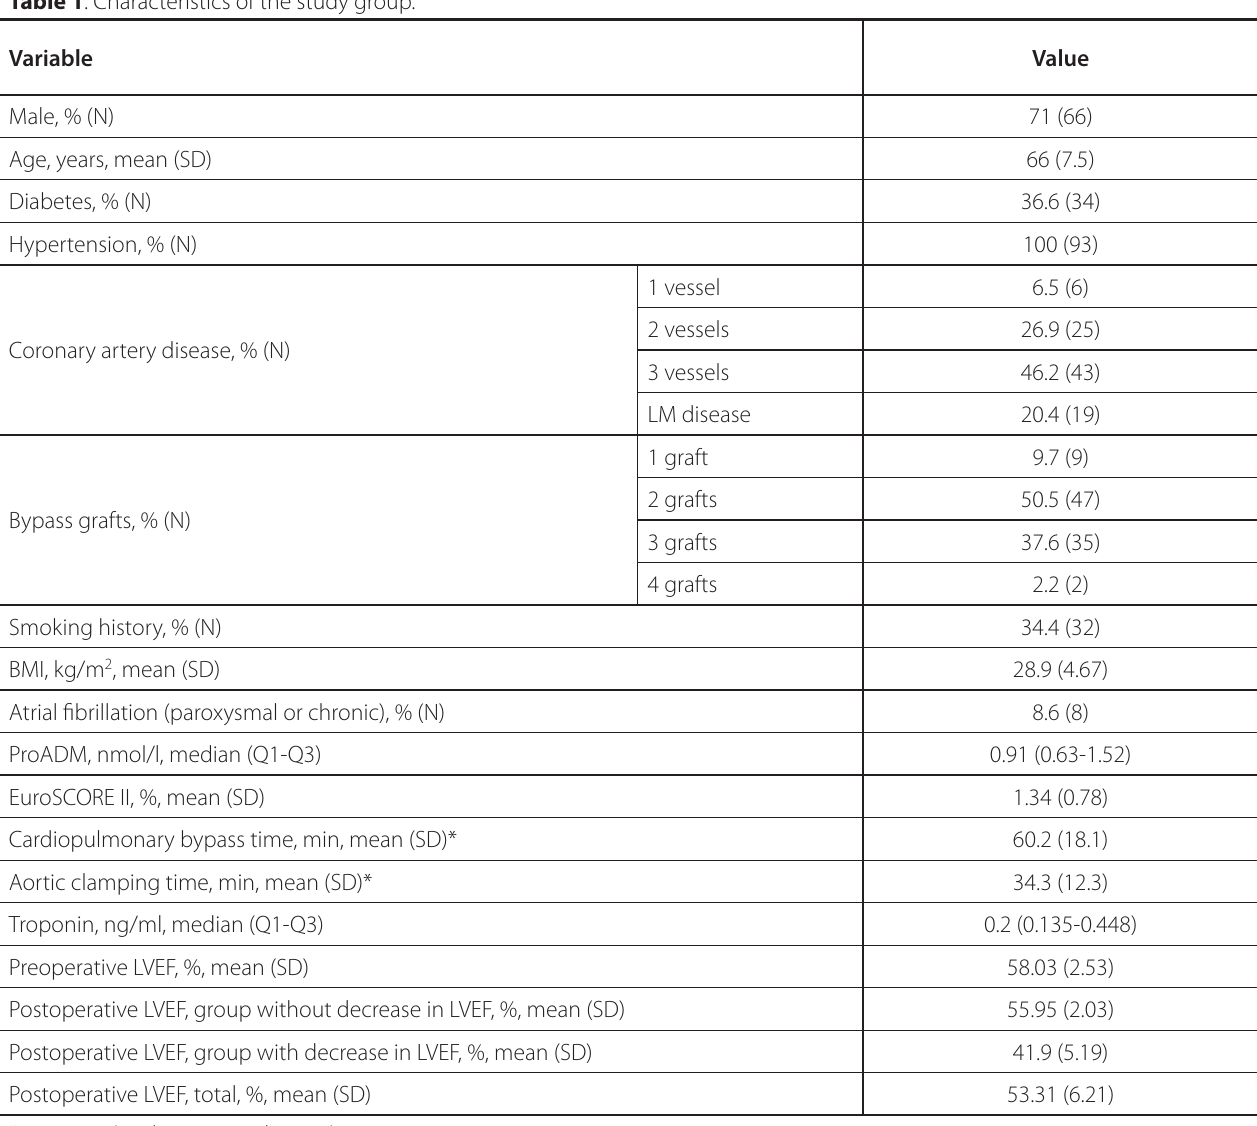
Table 1 . Characteristics of the study group.